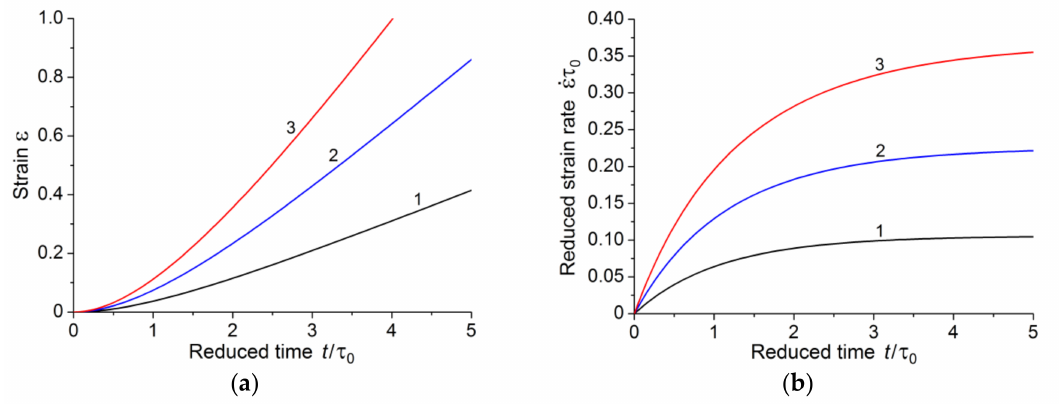
. ξ = ( B / η ) . ε ( b ) with respect to